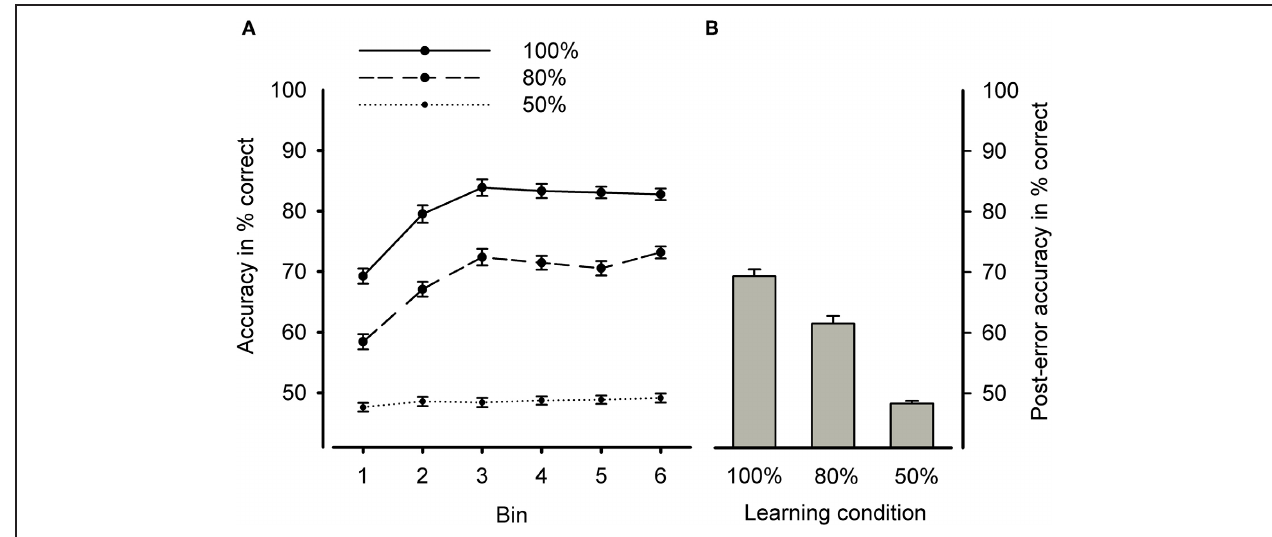
FIGURE 2 | (A) Learning curves (mean accuracy) for the three learning conditions. (B) Mean post-error accuracy rates (collapsed across bins) for the three learning conditions. Error bars indicate standard error.